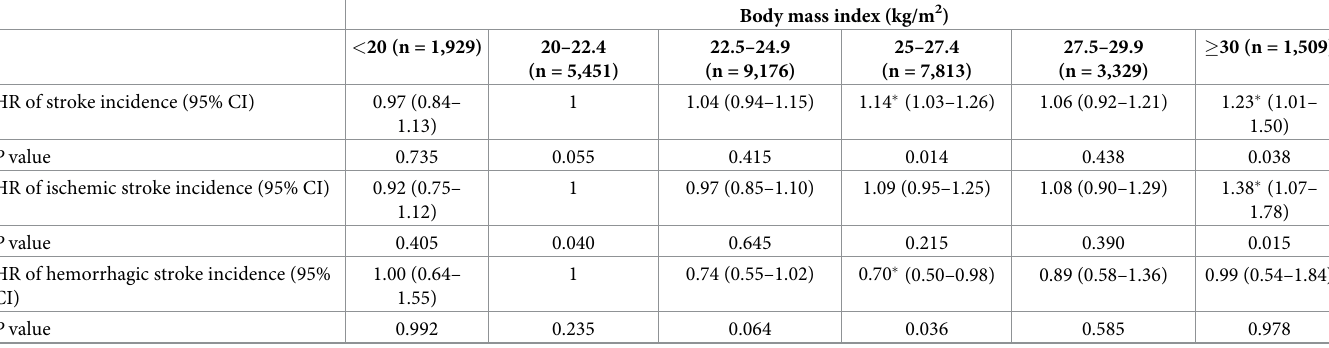
Table 2. Hazard ratios for stroke risk by different categories of body mass index among men with diabetes mellitus.